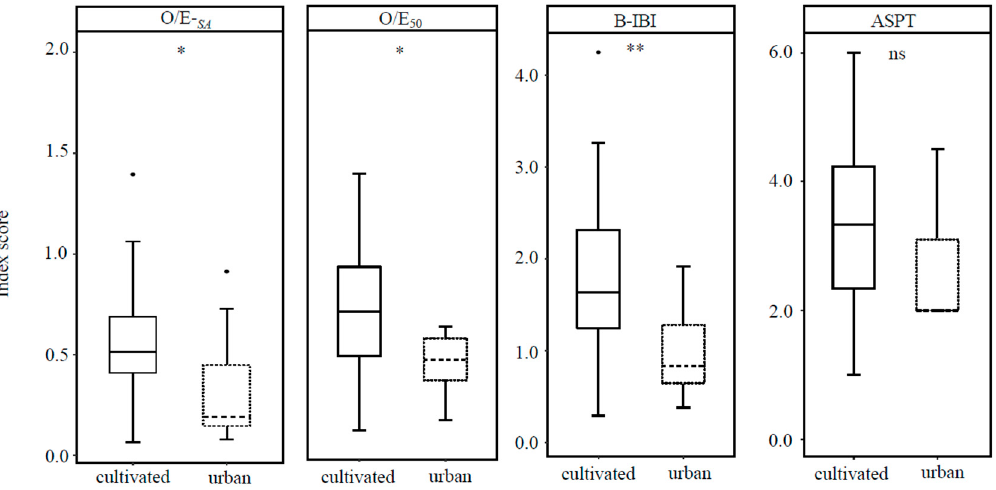
Figure 5. Box-plots of O/E- SA , O/E 50 , B-IBI, ASPT index scores in cultivated (solid line) and urban (dashed line) lakes. Boxes encompass the inter-quartiles, horizontal lines are medians, dots outside the box are outliers, and range bars show the maximum and minimum values excluding outliers. * = significance at p < 0.05 (Wilcoxon test) between index score in cultivated and urban lakes. ** = significance at p < 0.01. ns = no significant difference.